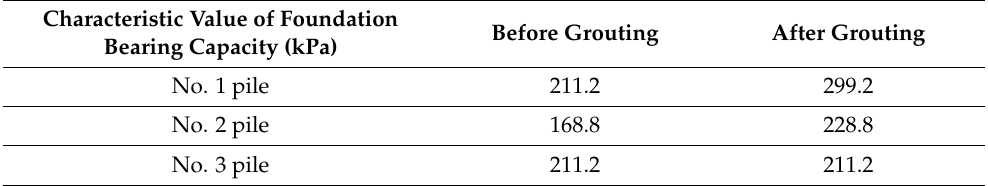
Table 4. Characteristic values of foundation bearing capacity before and after grouting. Characteristic Value of